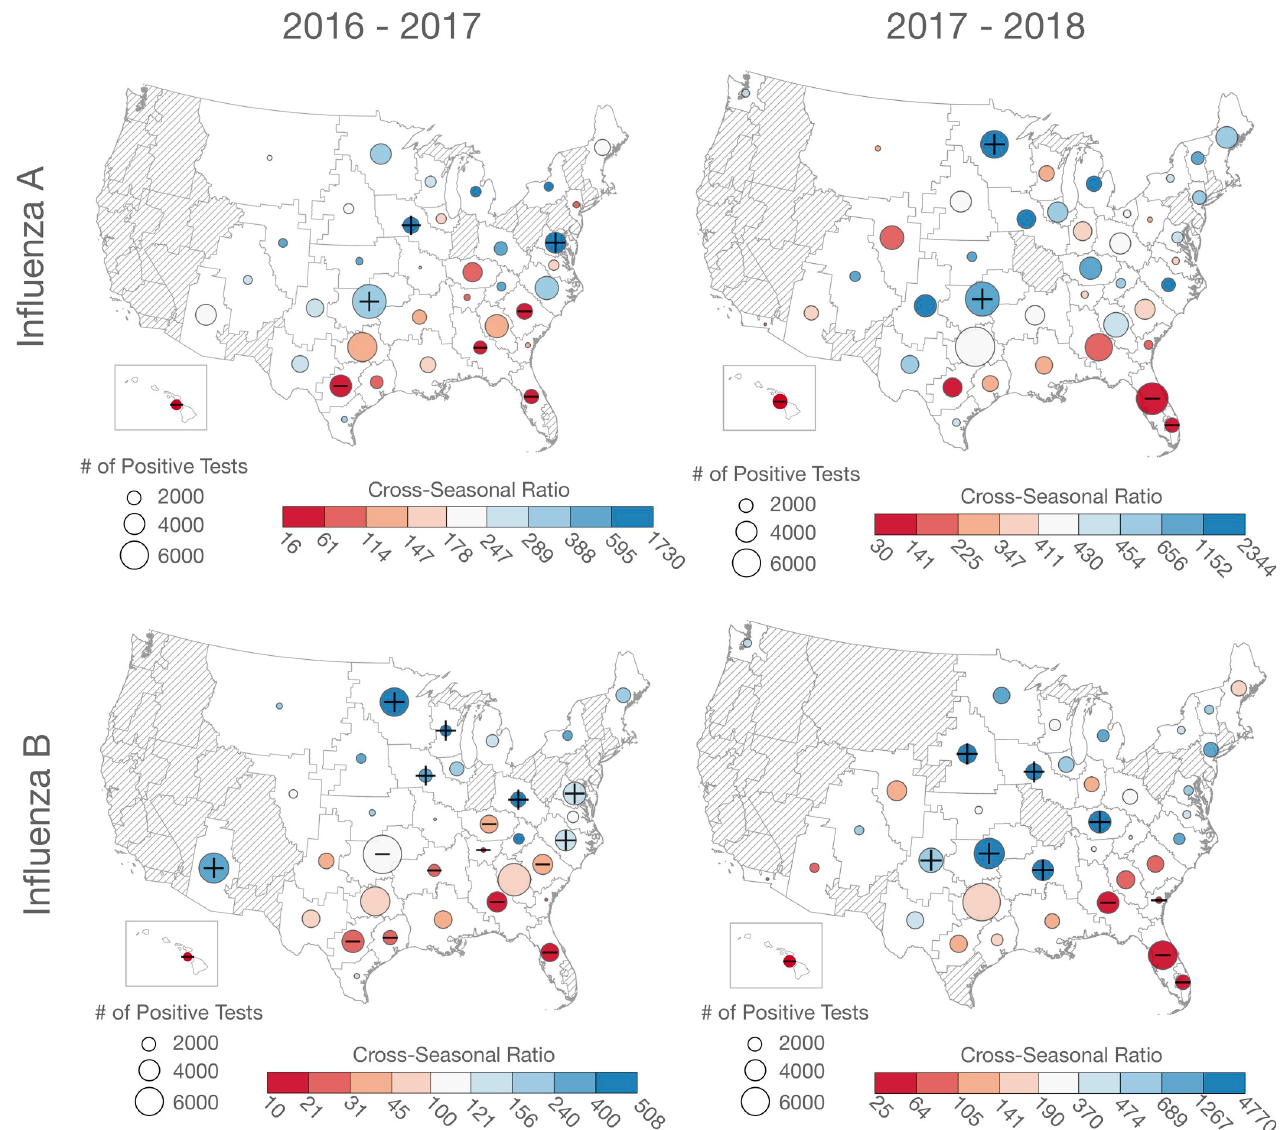
Fig 2. Maps of cross-seasonal ratios for each subregion by influenza year and type. Plus/minus symbols indicate subregions where the ratio was significantly below/above expected value (based on Fisher’s exact tests). Dashed areas are subregions with no or inadequate numbers of positive tests.